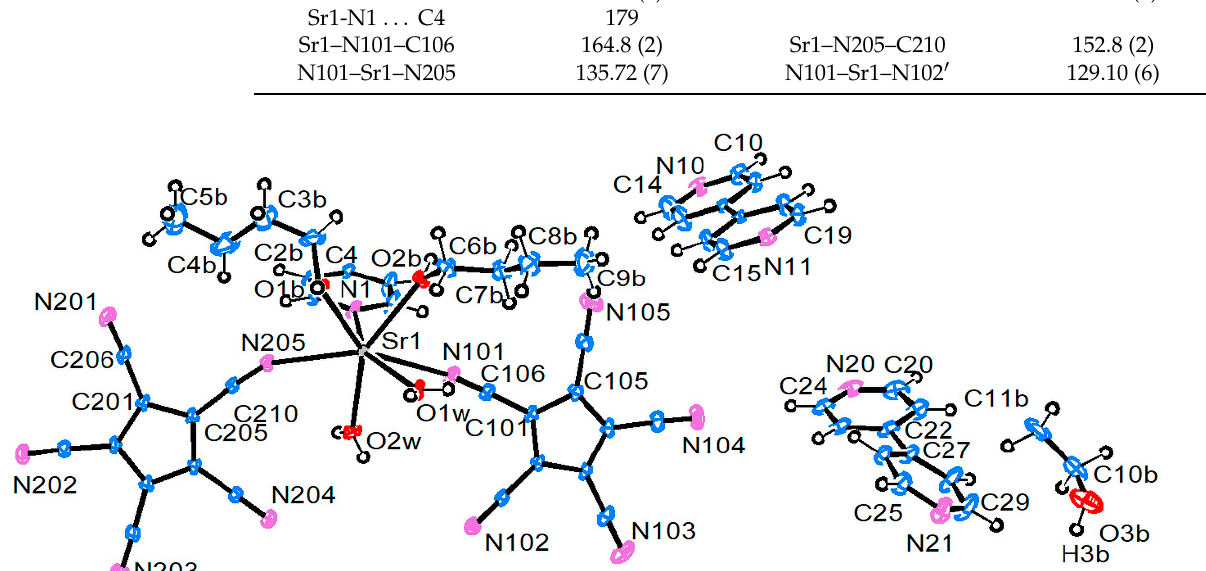
Compound 4 crystallizes in the triclinic space group P -1 with one molecule in the asymmetric unit (Figure 14). The molecular unit consists of a complex fragment [Sr(H 2 O) 2 (BuOH) 2 (PCC) 2 (4,4 ′ -bipy) 0 . 5 ] and two lattice 4,4 ′ -bipy molecules and a disor- dered half butanol (with partial occupancy). The disordered butanol is generated by an inversion center close to carbon atom C11b. The end atoms of the generated six atom chain are either a OH or a methyl hydrogen group.